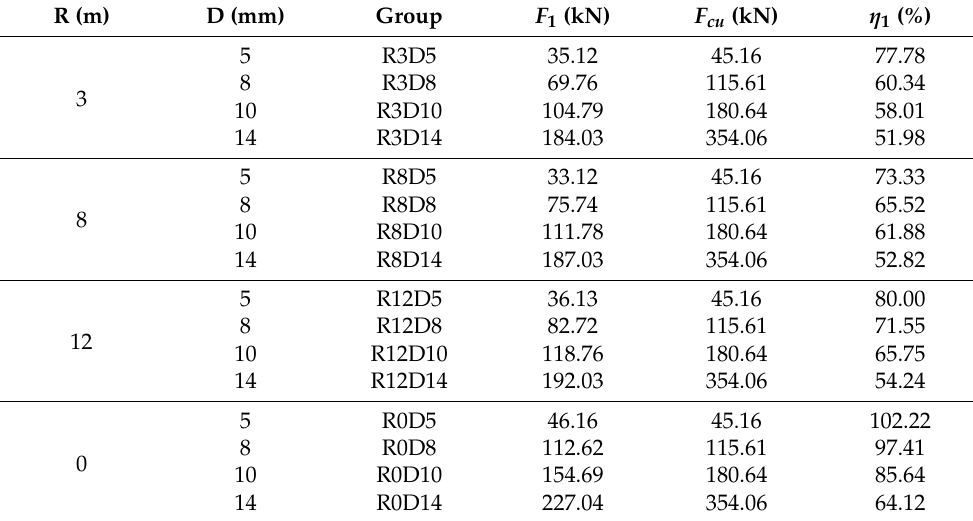
Table 3. Results of testing.